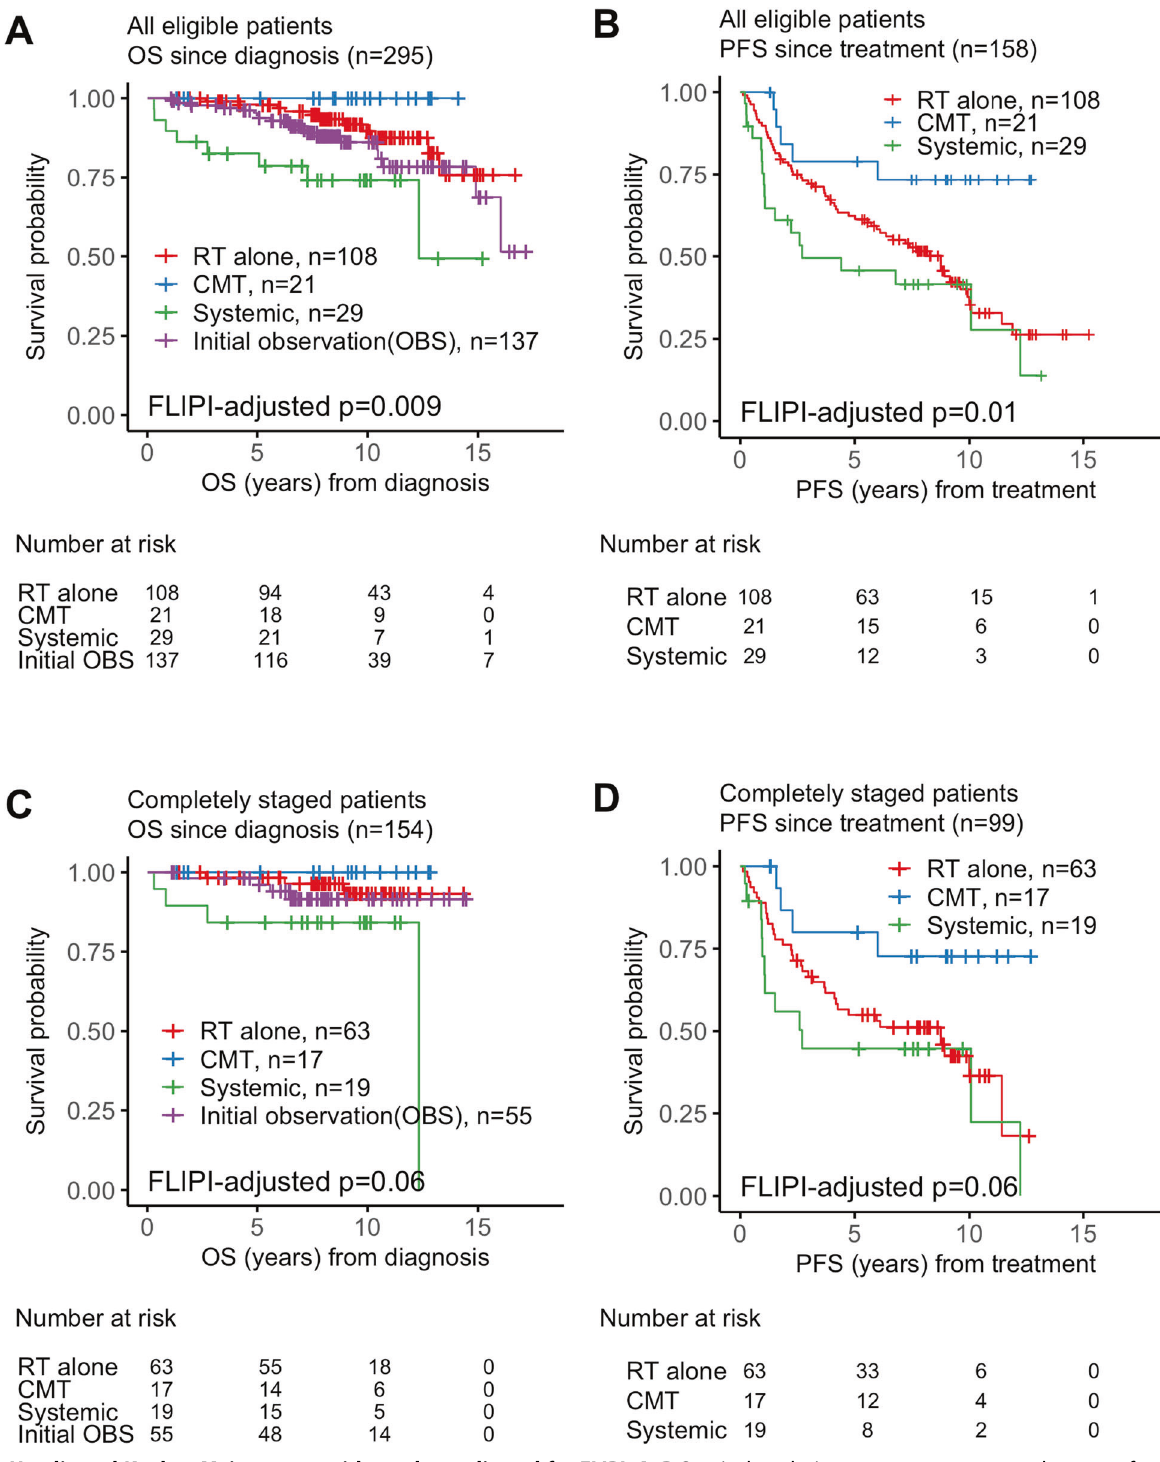
Fig. 4 Unadjusted Kaplan – Meier curves with p -values adjusted for FLIPI. A , B Survival analysis to compare outcomes by type of treatment received in all eligible stage I-II patients. A overall survival (OS) after diagnosis, B progression-free survival (PFS) after treatment, and C , D Survival analysis to compare outcomes by type of treatment received in stage I-II FL patients who were completely staged. C OS after diagnosis. D PFS after initially observed versus in patient who were immediately treated and 10 years after diagnosis was 4.2% and 10.8%, respectively. The (Supplemental Fig. S6). Patients selected for systemic treatment risk of death without transformation at 5 and 10 years after alone was observed to have higher risk of transformation at 5 years diagnosis was 3.9% and 10.8%, respectively. The aforementioned (18.4%) and 10 years (18.4%, fi gure not shown). competing risks were not signi fi cantly different in patient who were